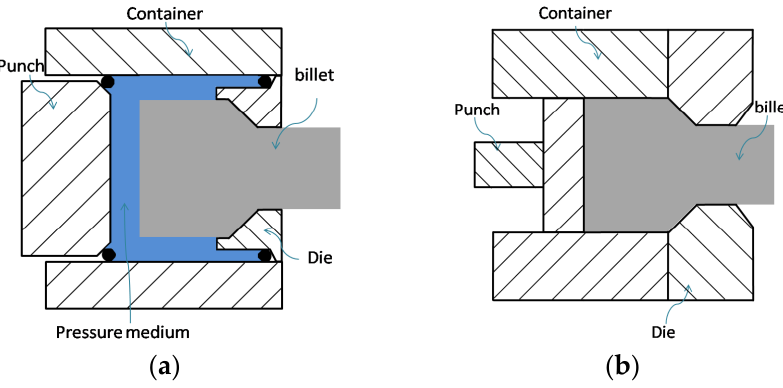
Figure 1. Principle of ( a ) hydrostatic extrusion and ( b ) conventional extrusion.